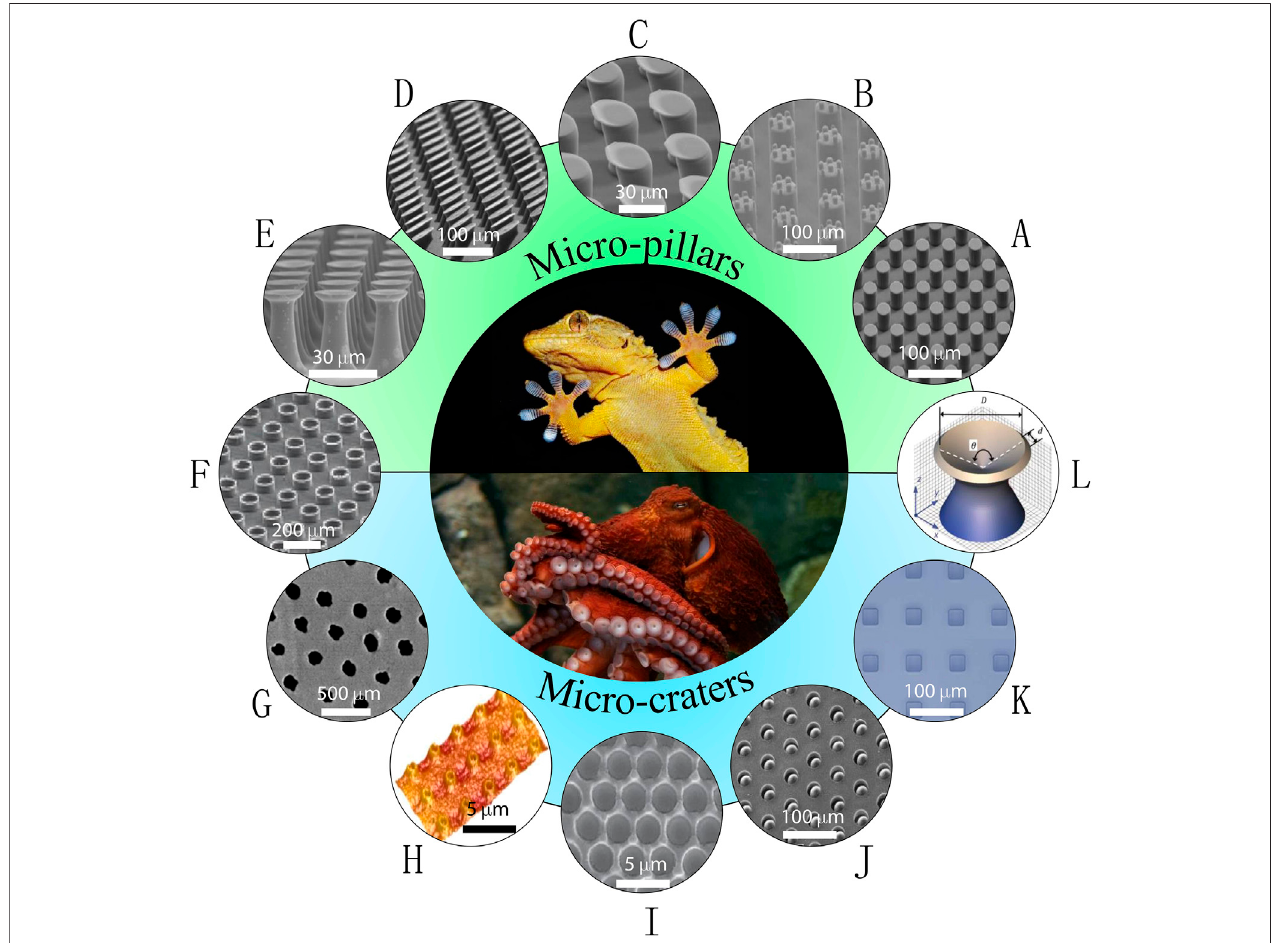
FIGURE 1 | Examples of nature-inspired soft dry adhesives (SDAs). (A – E) Gecko-inspired synthetic micro-pillars with various tip geometries: (A) fl at tip (reprinted withpermissionfromref(DelCampoetal.,2007b)); (B) hierarchicaltip(reprintedwithpermissionfromref(Greineretal.,2009)); (C) spatulartip(reprintedwithpermission from ref (Del Campo and Arzt, 2007)); (D) slanted tip (reprinted with permission from ref (Murphy et al., 2009)); (E) mushroom-like tip (reprinted with permission from ref (Wang et al., 2014)). (F) A combinational structure – micro-pillars with concave tip (reprinted with permission from ref (Baik et al., 2018)). (G – K) Octopus-inspired syntheticmicro-suckersorcraters: (G) nano-cratersonUVresinsurfaces(reprintedwithpermissionfromref(Changetal.,2014)); (H) reversibleadhesiveskinpatchwith micro-craters on multilayer PDMS (reprinted with permission from ref (Choi et al., 2016)); (I) micro-craters on PDMS surface (reprinted with permission from ref (Akerboom et al., 2015)); (J) micro-craters with interior protuberances (reprinted with permission from ref (Baik et al., 2017)); (K) square-patterned micro-craters on PDMS surface (reprinted withpermissionfrom ref (Nanni et al., 2015)). (L) Another combinational structure – pillar withfunnel-shaped tip (reprinted with permission from ref (Fischer et al.,